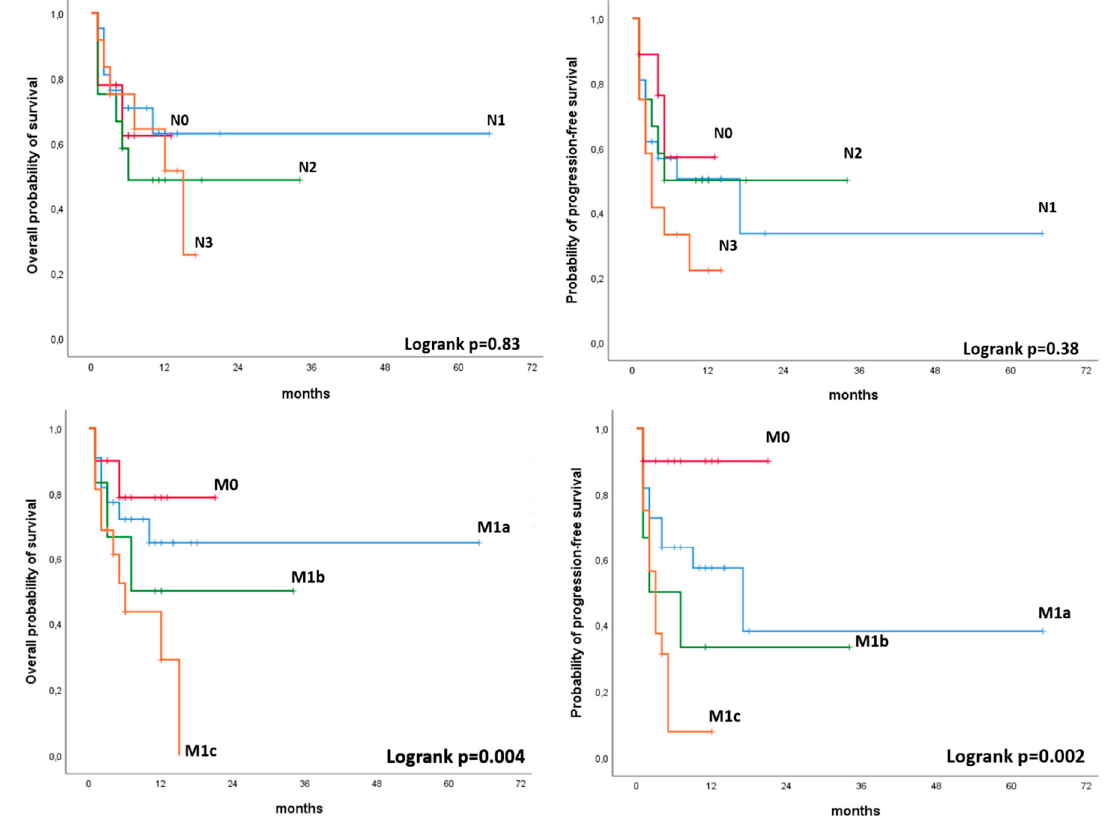
Figure 5. Kaplan–Meier plot analysis for N status (N0, N1, N2, N3) and M status (M0, M1a, M1b, M1c) with PFS and OS.